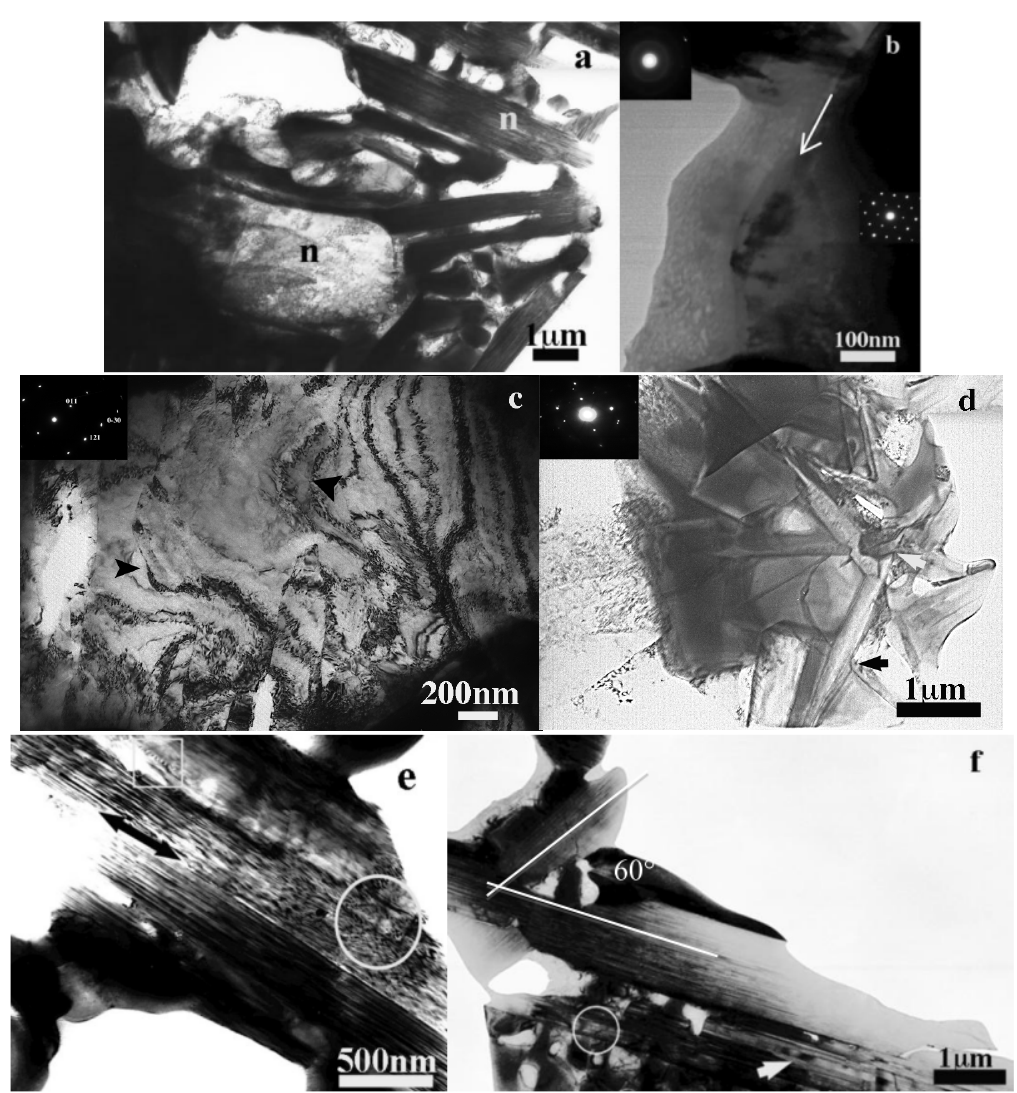
Figure 13. TEM-BF micrographs of Fe 8 mm diameter ingot: ( a ) Image of acicular microstructure; ( b ) Image of an amorphous pocket; ( c ) Image of acicular microstructure with bending contrast and dislocations; ( d ) Image of needles network. ( e , f ) Image of row of lamellae within a needle and needles crossing